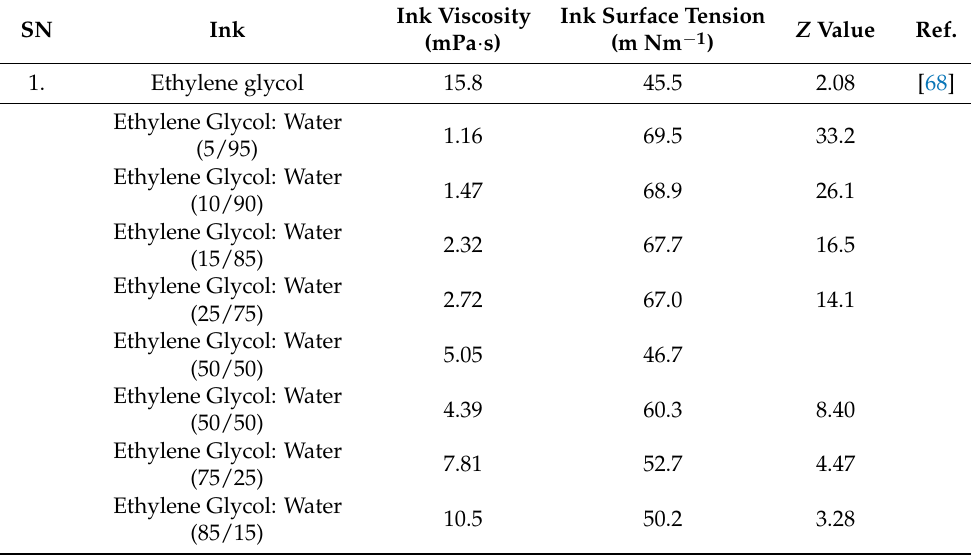
Table 2. Some of the recently used inks in inkjet printing.